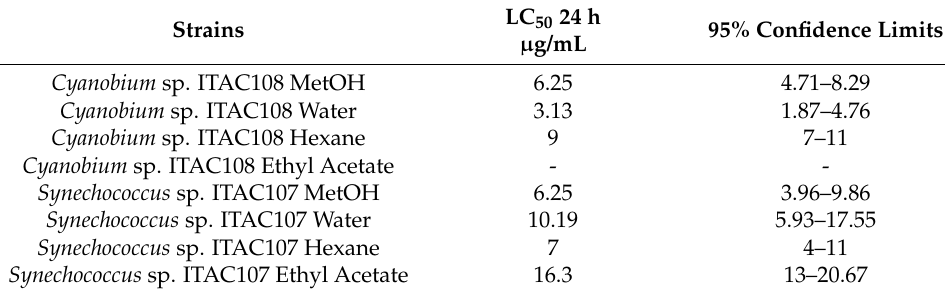
Table 1. The 24 h LC 50 values (with 95% confidence limits) for A. salina exposed to cyanobacterial extracts.